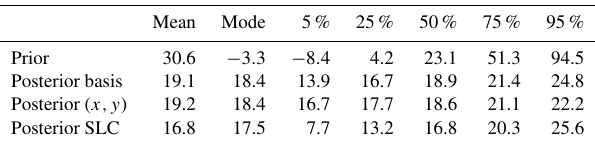
Table 1. Total sea level contribution after 50 years in mmSLE: (weighted) mean, most likely contribution and percentiles, with and without